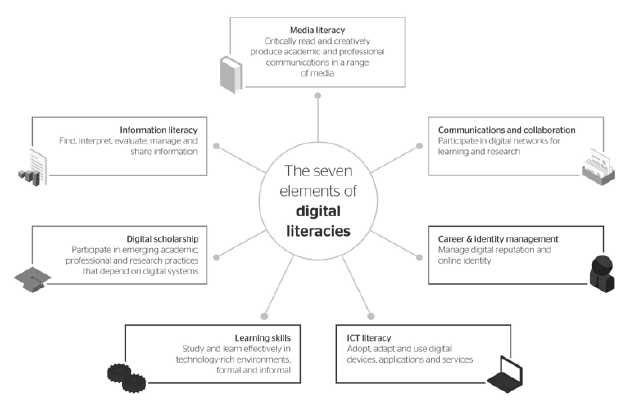
Figure 1 Seven capabilities of digital literacies introduced in 2009 [11]